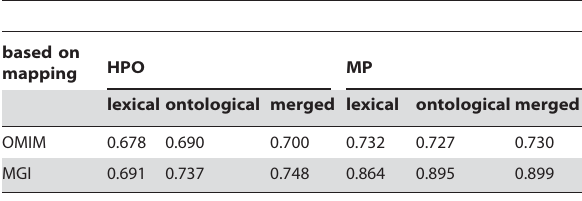
Table 2. Areas Under Curve (AUC) measures for all gene prediction tasks.